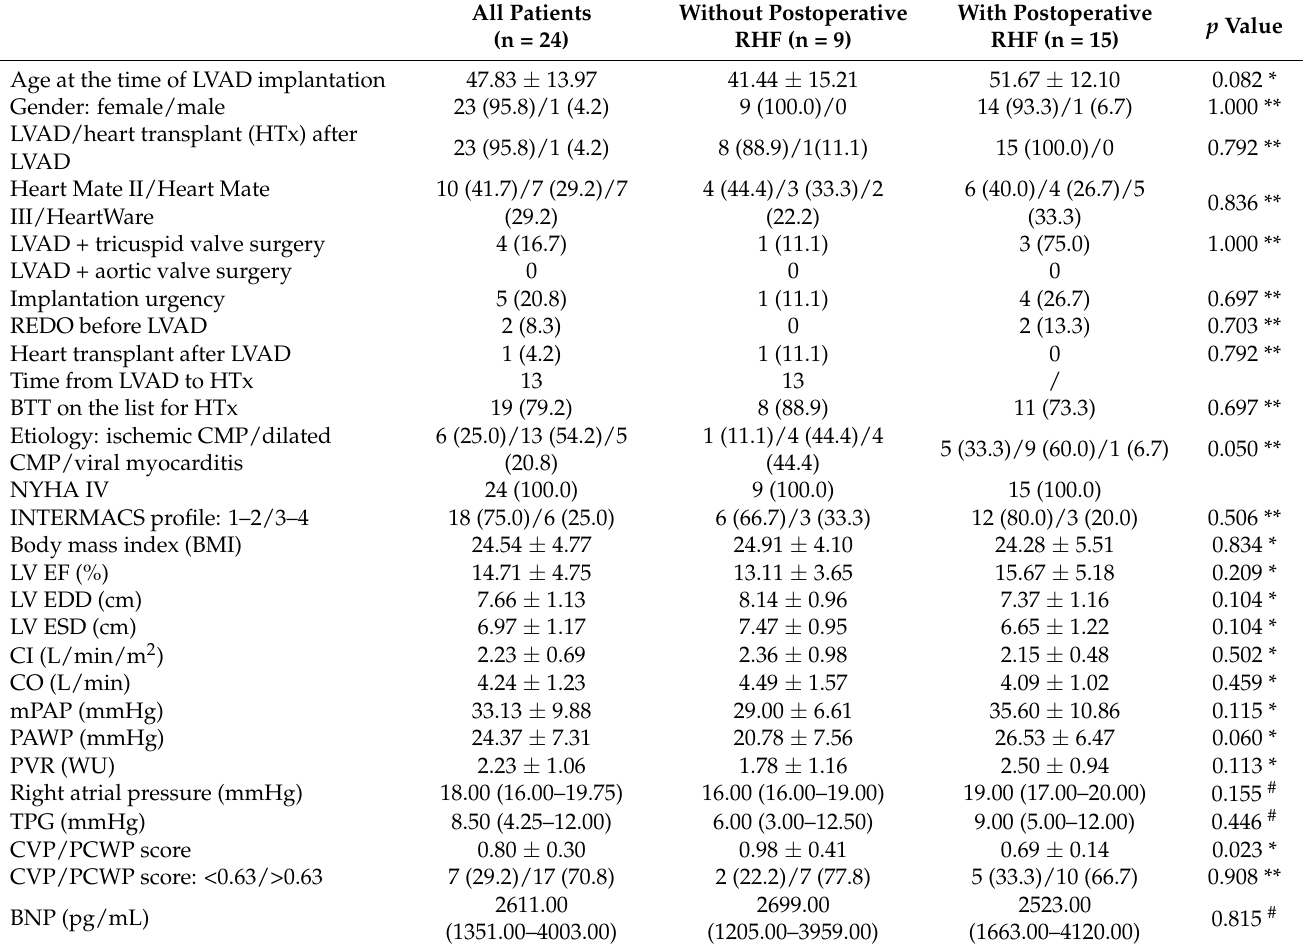
Table 6. Comparison of data in the 24 patients with pre-operative RHF by the development of postoperative RHF after LVAD